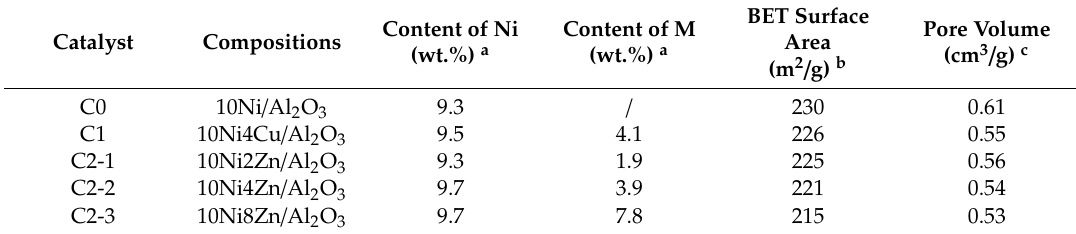
Table 2. The catalyst compositions of NiM / Al 2 O 3